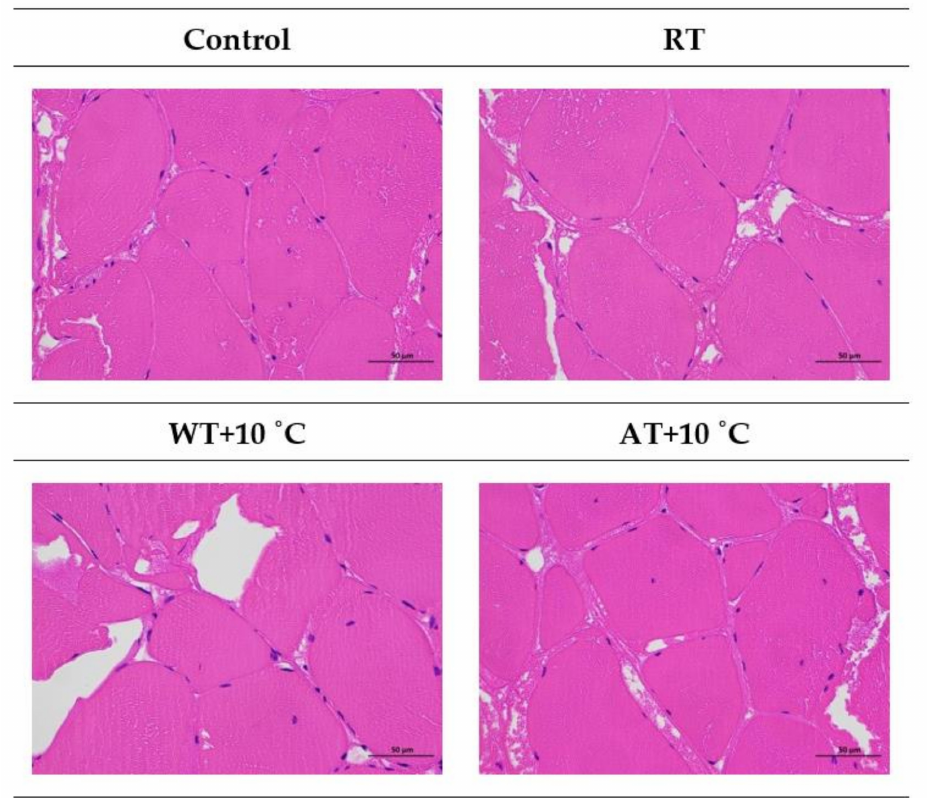
Figure 8. Microstructure of salmon fillet tissues after different tempering methods under light microscope (magnification × 400). (RT: Radio frequency tempering; WT + 10 ◦ C: Water tempering at 10 ± 0.5 ◦ C; AT + 10 ◦ C: Air tempering at 10 ± 1 ◦